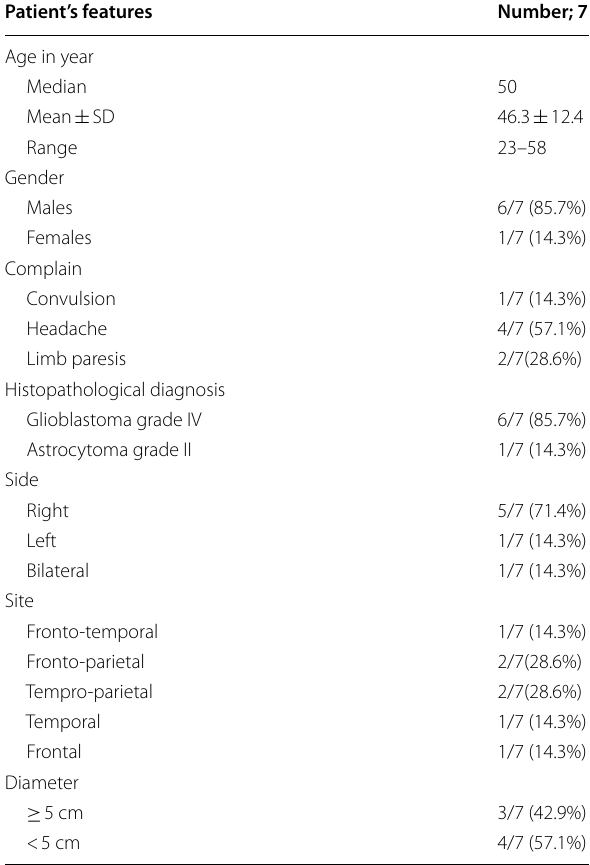
Table 1 Clinicopathological features of studied